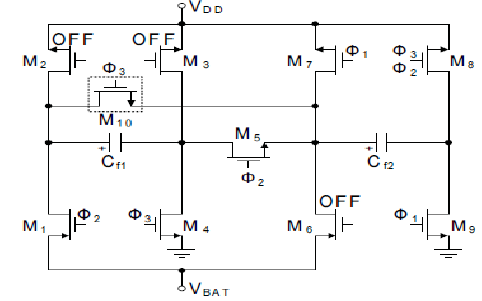
Figure 3. Existing CMOS switched capacitor circuit.